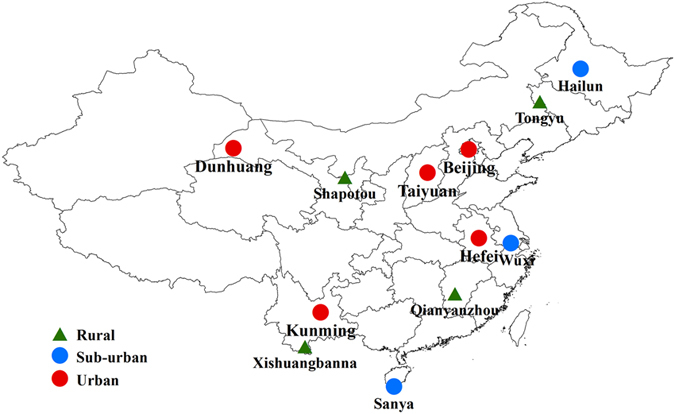
Sampling sites in China, including five urban sites: Beijing (BJ), Taiyuan (TY), Hefei (HF), Kunming (KM), and Dunhuang (DH), three sub-urban sites: Hailun (HL), Wuxi (WX), and Sanya (SY), four rural sites: Tongyu (TYU), Shapotou (SPT), Qianyanzhou (QYZ) and Xishuangbanna (BN).The figure is created by ArcGIS 10.1.